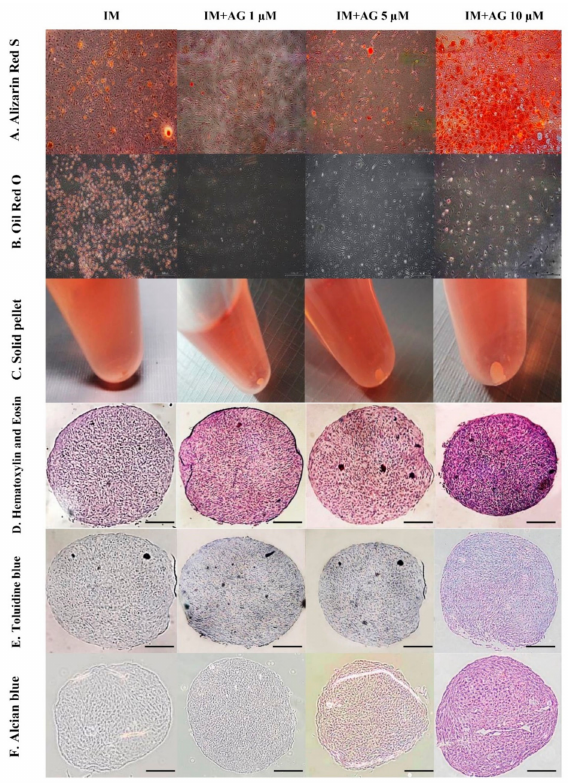
Figure 4. The effects of different doses of AG (1, 5 and 10 µM) with specific induction medium (IM) of each differentiation type on tri-lineage differentiation potentials of cells from SPFP-MSCs on day 21 compared with specific induction medium without AG as control. The scale bar ▬▬ in ( A , B , D – F ) represents 500 µm and 200 µm, respectively. ( A ) Osteogenic differentiation; Alizarin red S staining reflected that the calcium droplets. ( B ) Adipogenic differentiation; Oil Red O stain- ing reflected that lipid droplets. ( C ) Chondrogenic differentiation; After a cell pellet was treated with chondrogenic medium and chondrogenic medium with AG. ( D ) Pellet cultures of SPFP- MSCs were sectioned and stained with Hematoxylin & Eosin reflected that morphology. ( E ) Pellet cultures of SPFP-MSCs were sectioned and stained with toluidine blue reflected that glycosamino- glycans. ( F ) Pellet cultures of SPFP-MSCs were sectioned and stained with alcian blue reflected that proteoglycans.